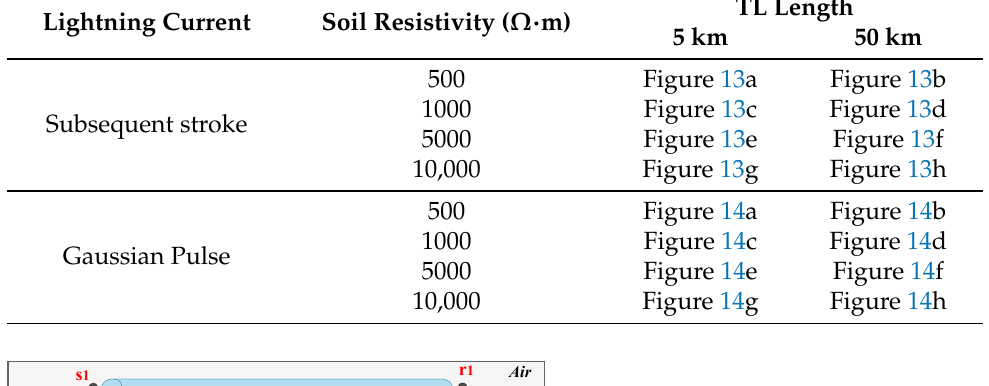
Table 5. Simulation results for the double-circuit three-phase TL of Figure 12. Lightning Current